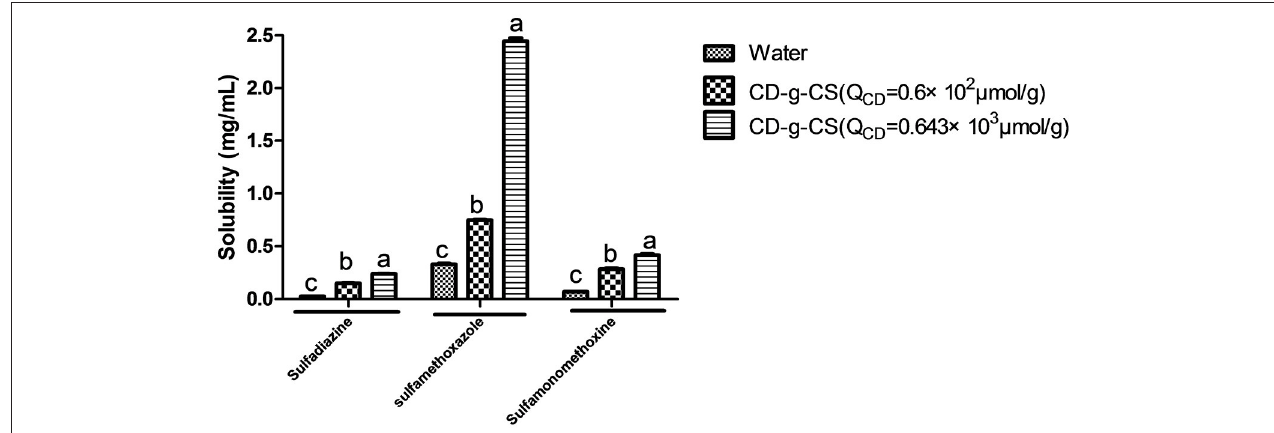
FIGURE 9 | Effect of CD-g-CS on the solubility of sulfadiazine, sulfamonomethoxine and sulfamethoxazole. Different letters indicate a significant difference at p ≤ 0.05. Data are expressed as mean ± standard deviation ( n = 3).